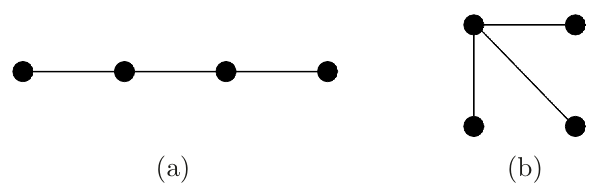
Figure 2 . The two trees with three edges: ( a ) Tree with vertices of degrees (1,2,2,1). ( b ) Tree with vertices of degrees (3,1,1,1). There are 16 ways to color each of